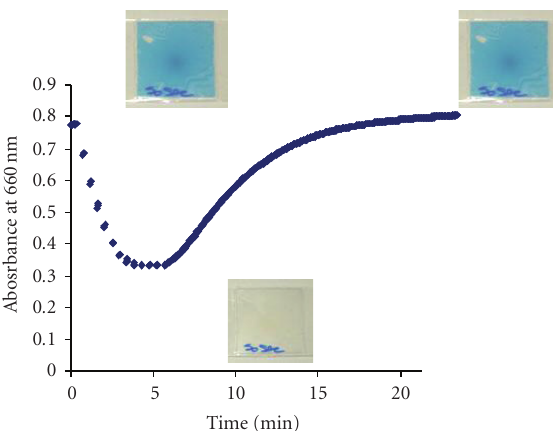
Figure 2: Colourimetric UVA dosimetric indicators—UVA expo- sure photo-reduced MB (blue) the LMB (white) (UVA dose = 9.0kJ/m 2 ), MB subsequently reformed via oxidation in the dark.